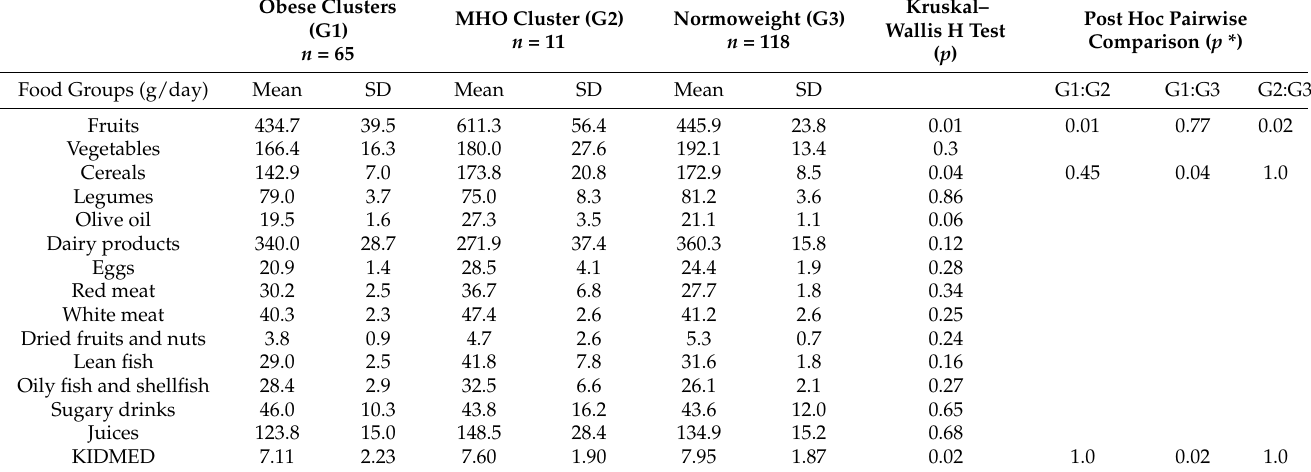
Table 4. Food groups